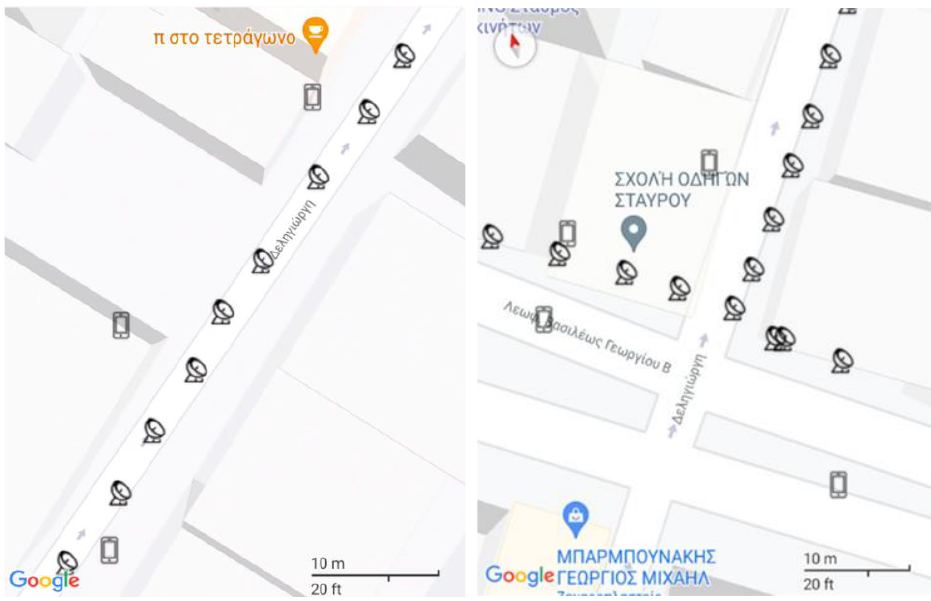
Figure 4. ( right and left ). Great accuracy and tracking density.